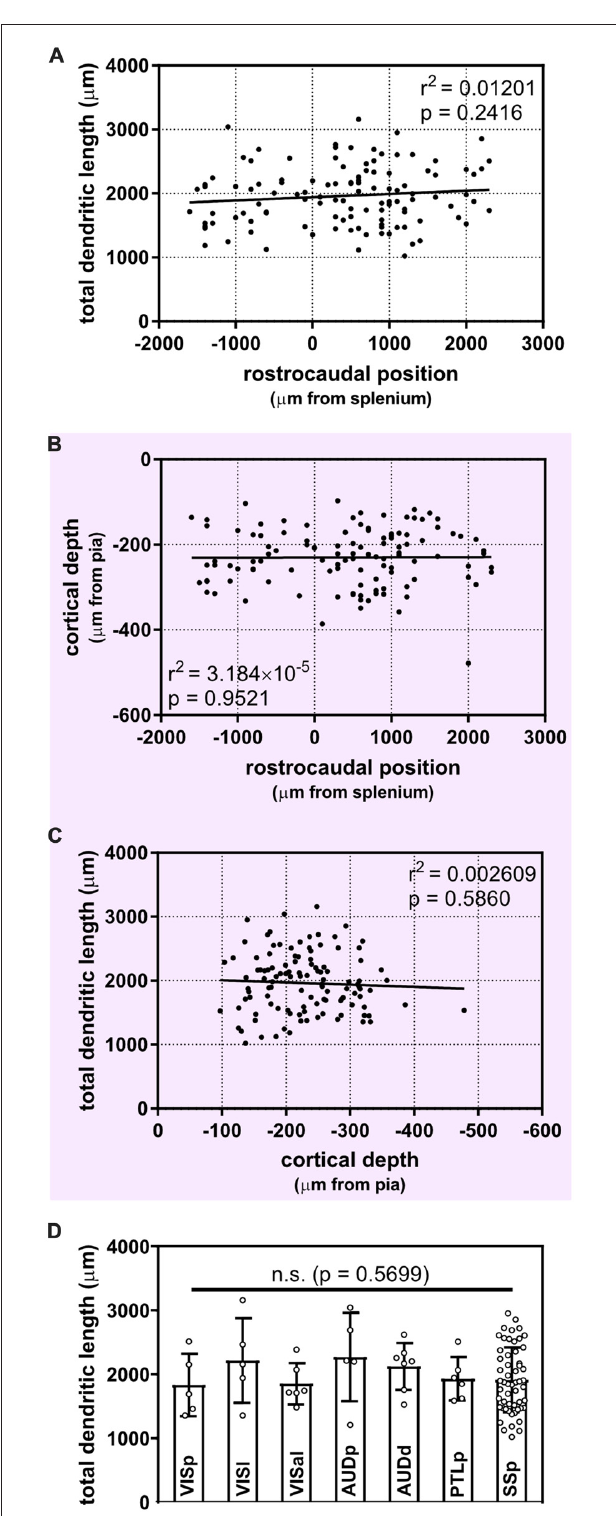
FIGURE 3 | Uniform morphological heterogeneity in supragranular pyramidal neurons across the rostrocaudal axis, cortical depth and functional regions of the mouse. (A) No apparent relationship between the position of neurons